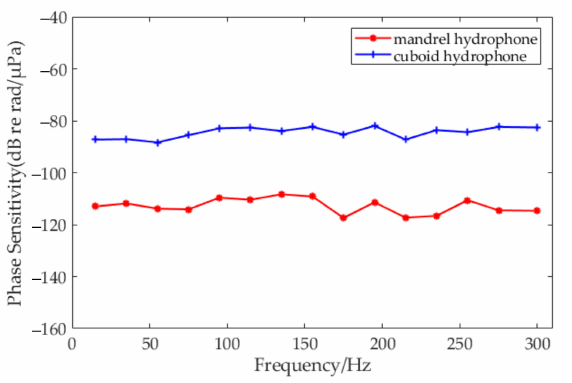
Figure 9. Frequency response of two developed hydrophones in 10–300 Hz range.